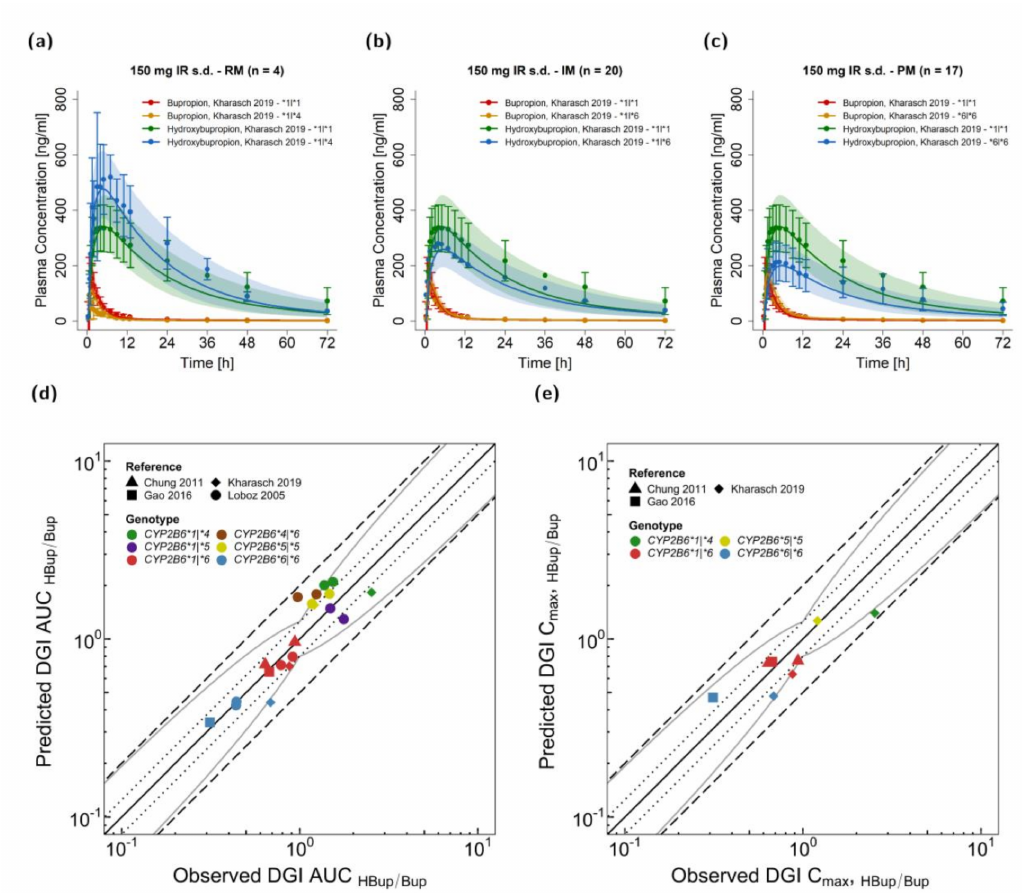
Figure 4. Bupropion CYP2B6 DGI model evaluation. Predicted compared to observed plasma concentration-time profiles are illustrated for CYP2B6*1/*4 ( a ), CYP2B6*1/*6 ( b ) and CYP2B6*6/*6 ( c ) genotypes [17] in comparison to the CYP2B6*1/*1 genotype (wildtype, n = 21). The effects of respective genetic variants of CYP2B6 are shown in orange and blue for bupropion and hydroxybupropion, respectively; the corresponding profiles of the CYP2B6*1/*1 genotype are shown in red and green for bupropion and hydroxybupropion, respectively. The solid line illustrates the geometric mean of the population predictions ( n = 500) and the shaded area the geometric standard deviation. Predicted compared to observed DGI effect ratios are shown for hydroxybupropion–bupropion ratios of AUC ( d ) and C max ( e ) with different colors indicating the genotypes and different shapes the respective studies [17,35,40,44]. The straight solid line marks the line of identity, the curved solid lines show the prediction acceptance limits proposed by Guest et al. including 1.25-fold variability [85]. Dotted lines indicate 1.25-fold and dashed lines indicate 2-fold deviation. Details on the study protocols and DGI ratios are provided in the Supplementary Materials. AUC: area under the plasma concentration-time curve, C max : maximum plasma concentration, DGI: drug–gene interaction, HBup/Bup: hydroxybupropion–bupropion ratio, IM: intermediate